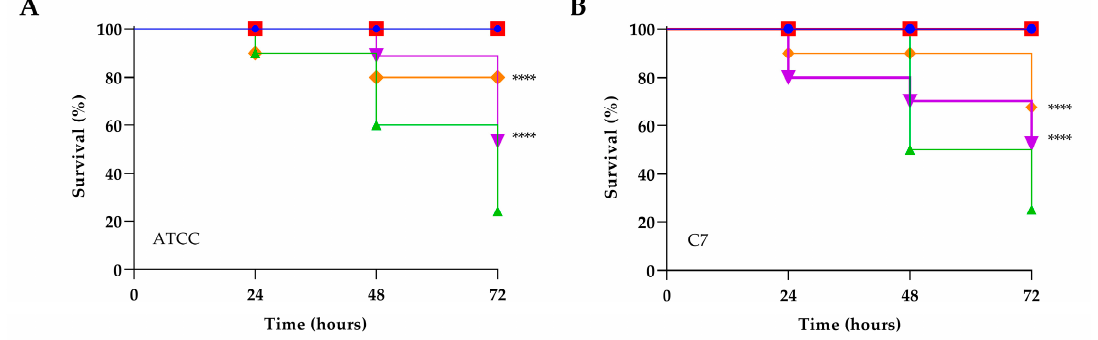
Figure 8. Kaplan–Meier plots of survival curves of G. mellonella larvae infected with C. albicans ATCC90028 ( A ), C7 ( B ), C14 ( C ), C17 ( D ), and C19 ( E ). The concentration of microorganisms was 1 × 10 6 CFU/larva. All groups were treated with 2.5 mg mL − 1 PLA before or after infection. All groups were compared with control (infected larvae). In all panels, survival curves of intact larvae and lar- vae injected with PBS are reported. **** represents p -value < 0.001 (Tukey’s). 4. Discussion VVC represent the most prevalent fungal infections that affects 5–8% of women of reproductive age with a considerable negative impact on the quality of their social and sexual lives. It is a difficult-to-manage infection because the complexity of its physio- pathology leads to a gradual increase in drug resistance toward common drugs, such as nystatin, miconazole, and fluconazole, the latter being the first-line treatment for VVC [33]. Moreover, the intrinsic biofilm formation ability of Candida spp. has been recognized as one of the major critical factors for the antimicrobial resistance able to cause harmful recurrent chronic fungal infections. The antimicrobial activity of natural products which are effective against several microbial organisms responsible for common infectious and